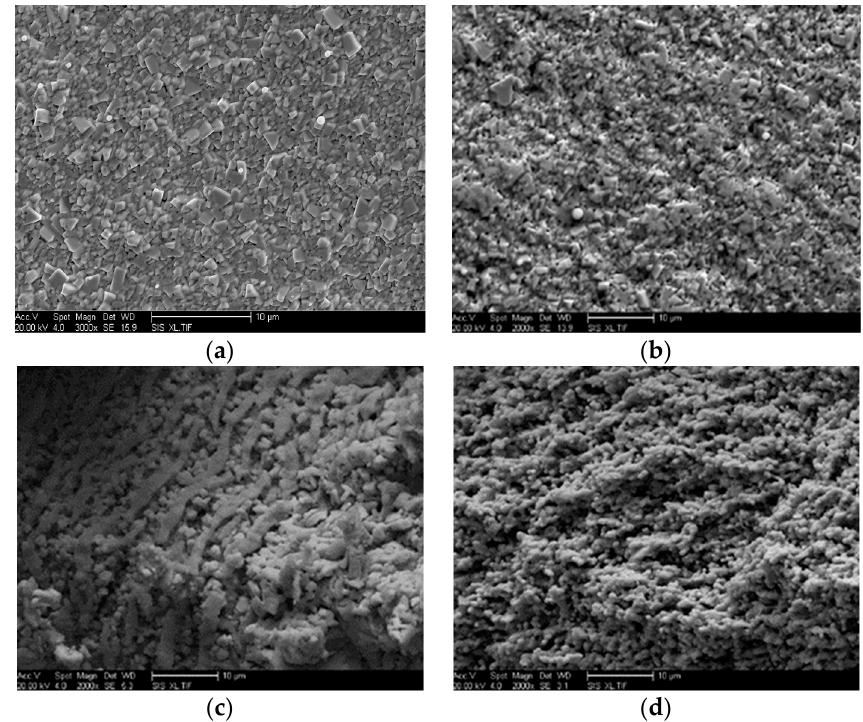
Figure 6. Oxidation morphology of WC/Co at different temperatures: ( a ) room temperature ( b ) 873 K, ( c ) 1173 K, and ( d ) 1273 K.